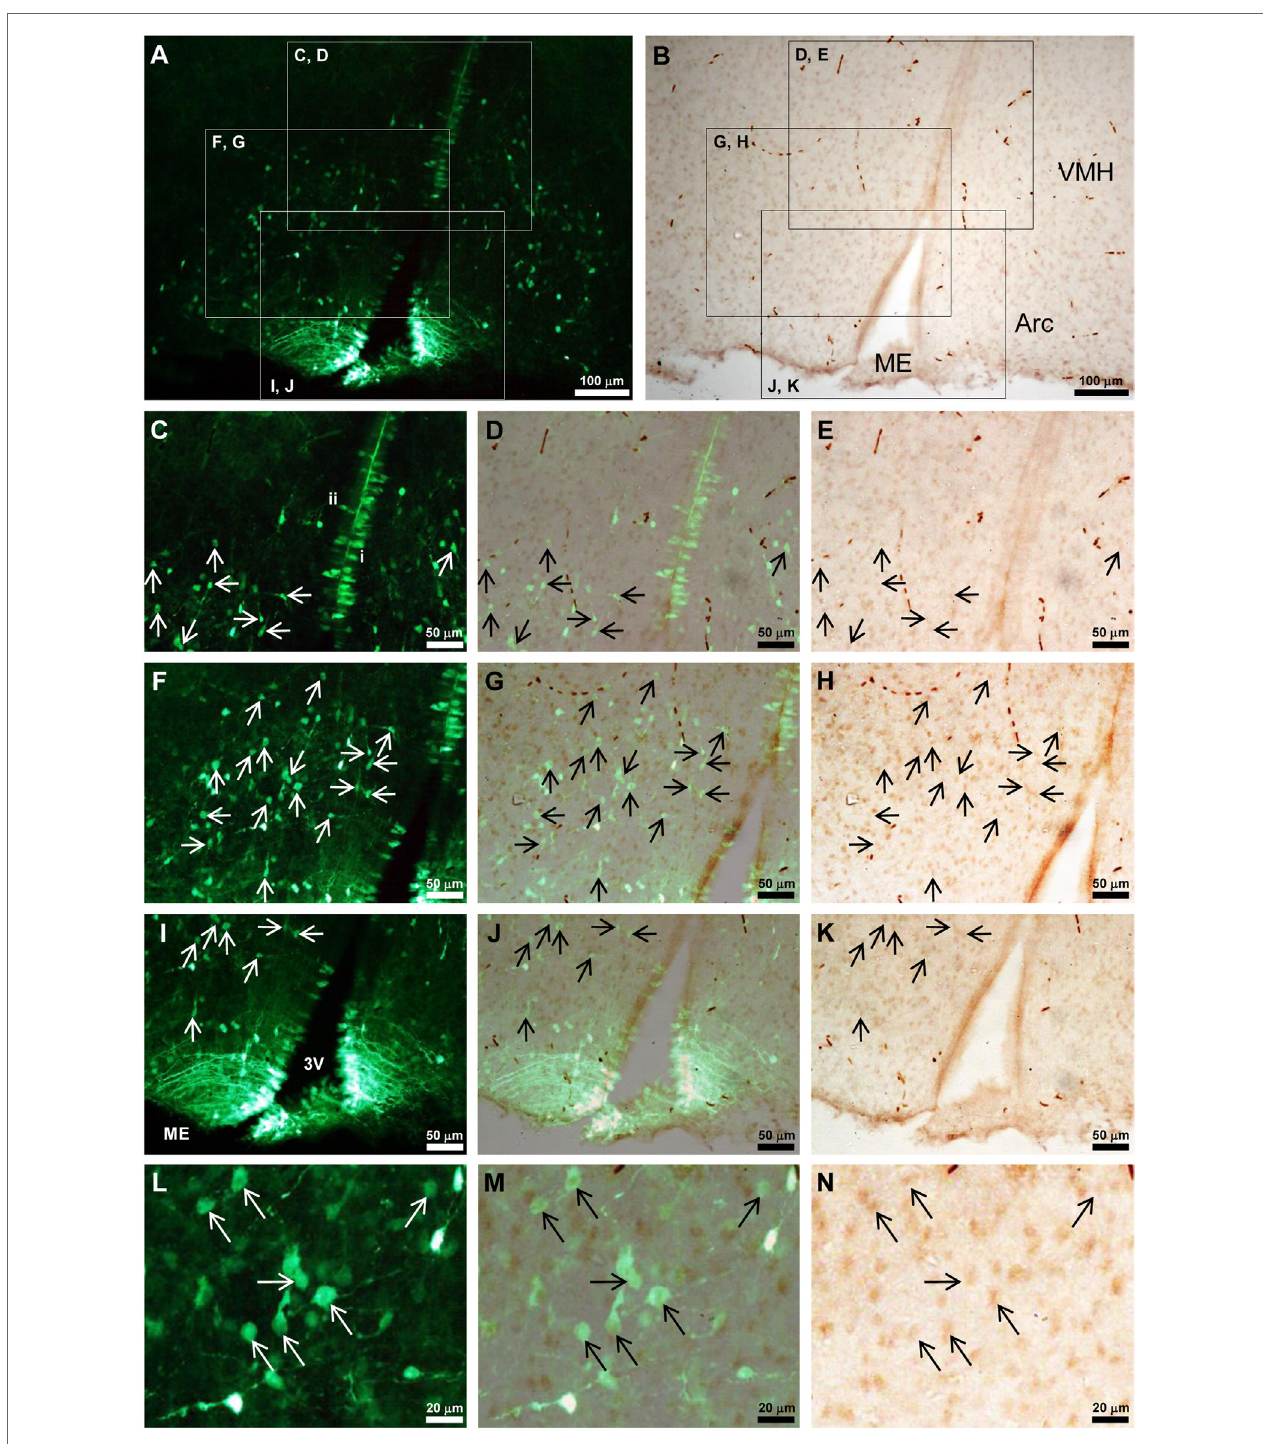
FigUre 5 | Tmprss2-immunoreactive EGFP-GnIH neurons in the hypothalamus of neonatal male rat. (a,b) EGFP-GnIH neurons (a) and Tmprss2-immunoreactive (ir) cells (b) in the identical field and focus of hypothalamus. VMH, ventromedial hypothalamic area; Arc, arcuate hypothalamic nucleus; ME, median eminence. (c–e) Higher magnification of highlighted area in panel (a,b) with identical focus. Panel (D) is the merged image of (c,e) . Arrows show Tmprss2-ir EGFP-GnIH neurons. [ (c) i] An example of ventricle contacting rod-like EGFP-GnIH cell. [ (c) ii] An example of EGFP-GnIH cell projecting its process to the ventricle. (F–h) Higher magnification of highlighted area in panel (a,b) with identical focus. Panel (g) is the merged image of (F,h) . Arrows show Tmprss2-ir EGFP-GnIH neurons. (i–K) Higher magnification of highlighted area in panel (a,b) with identical focus. Panel (J) is the merged image of (i,K) . Arrows show Tmprss2-ir EGFP-GnIH neurons. 3V, third ventricle. (l–n) Higher magnification of the central area in panel (F–h) with identical focus. Arrows show Tmprss2-ir EGFP-GnIH